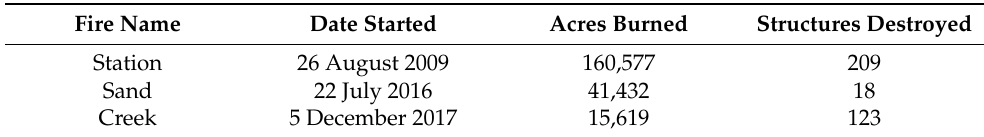
Table 1. Description of the fires that have affected the area of interest [17]. © 1998–2019 Given Place Media, publishing as Los Angeles Almanac. Reprinted with permission.